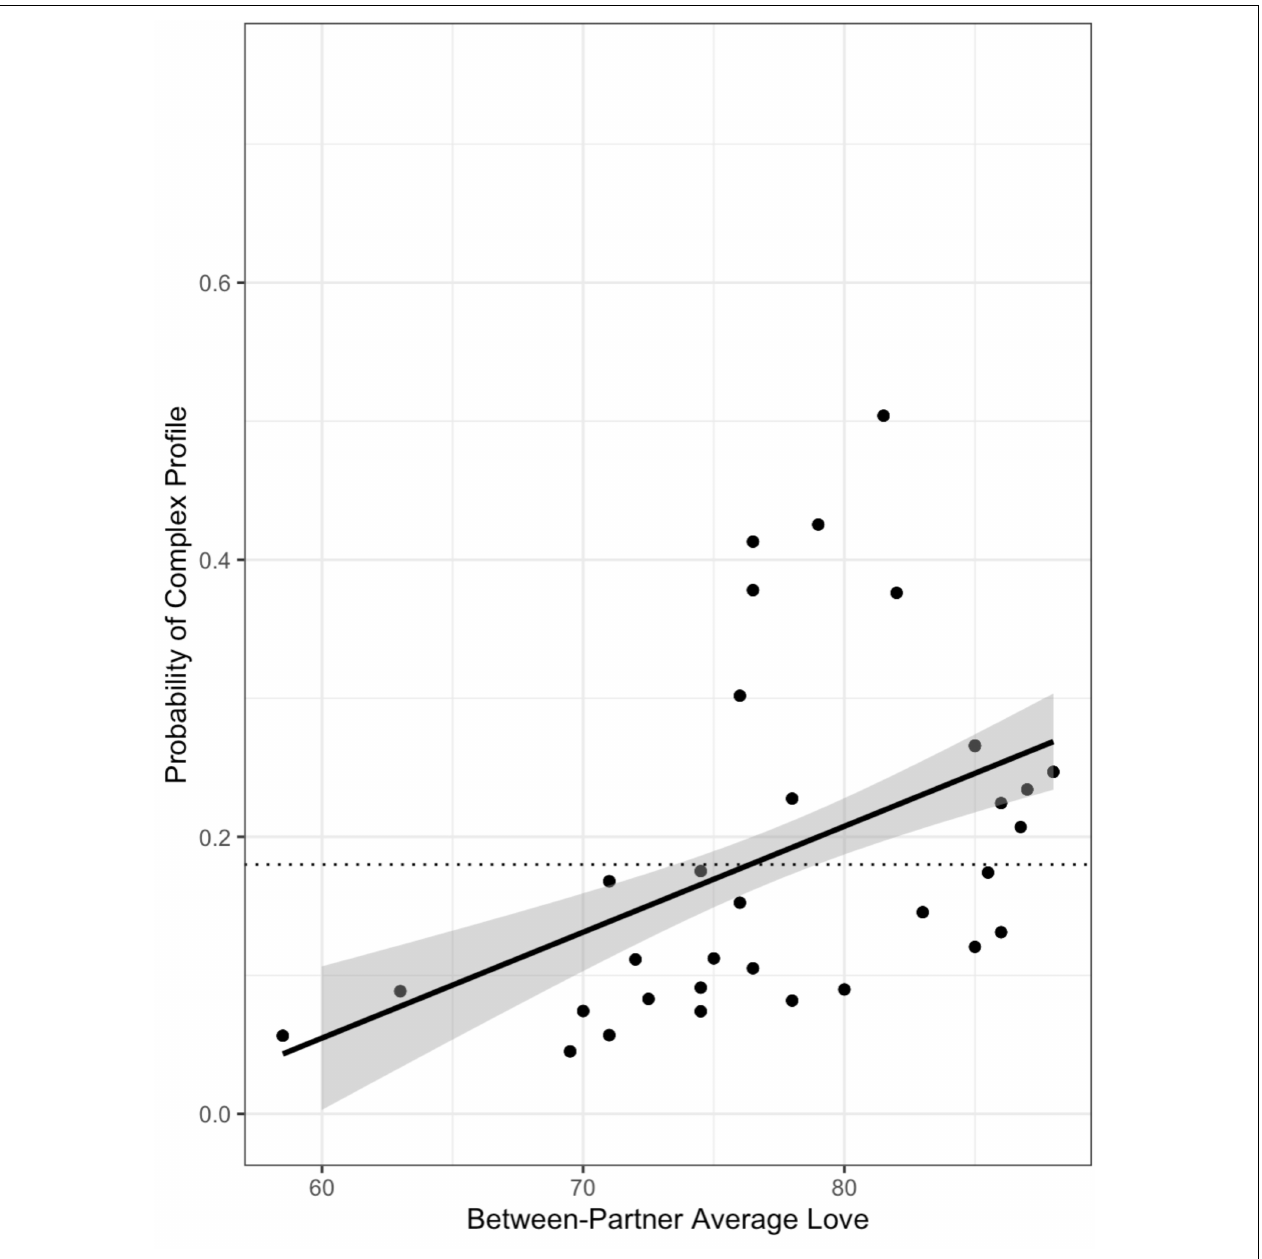
FIGURE 2 | The main effect of average love across contexts. The dotted line shows the unconditional probability of being in the complex profile as a reference point. Higher average love was associated with a higher probability of being in the complex profile across